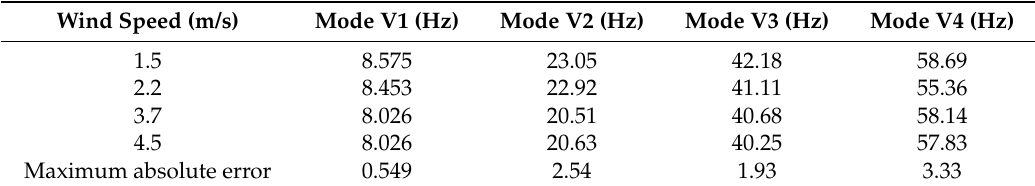
Table 3. Natural frequencies calculated by short-time Fourier transform (STFT).